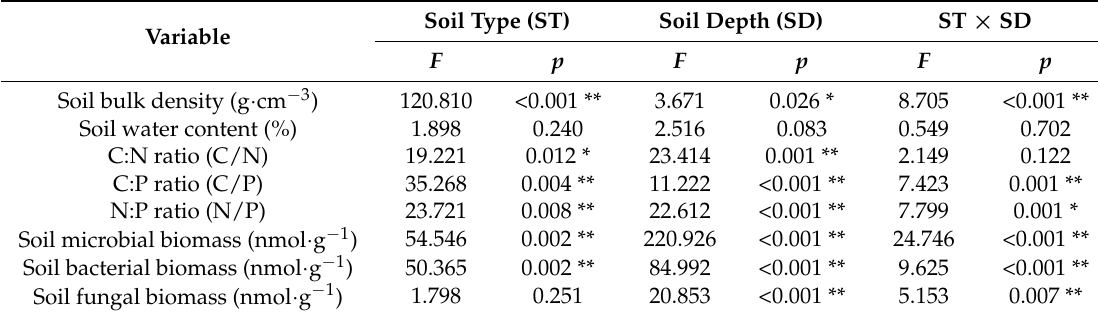
Table 2. Analysis of variance for soil physicochemical properties in two forest soil